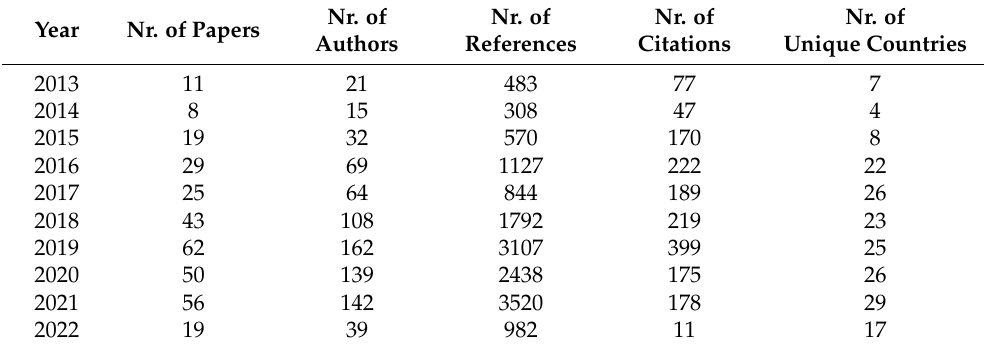
Table 2. General descriptives of Publications .